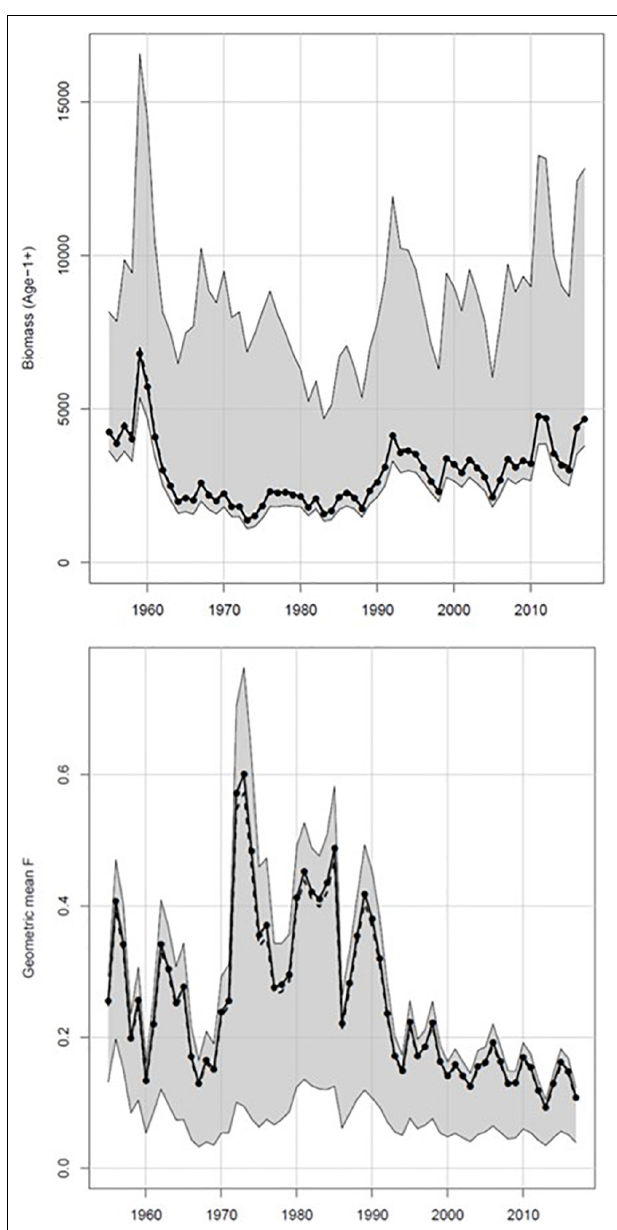
FIGURE 3 | Age 1+ biomass of Atlantic menhaden (in metric tons; top) and geometric mean fishing mortality rate ( F ) for ages-2 to -4 (bottom) with 95th percentiles from the Monte Carlo Bootstrap method as estimated in the most recent stock assessment (Southeast Data Assessment and Review [SEDAR],